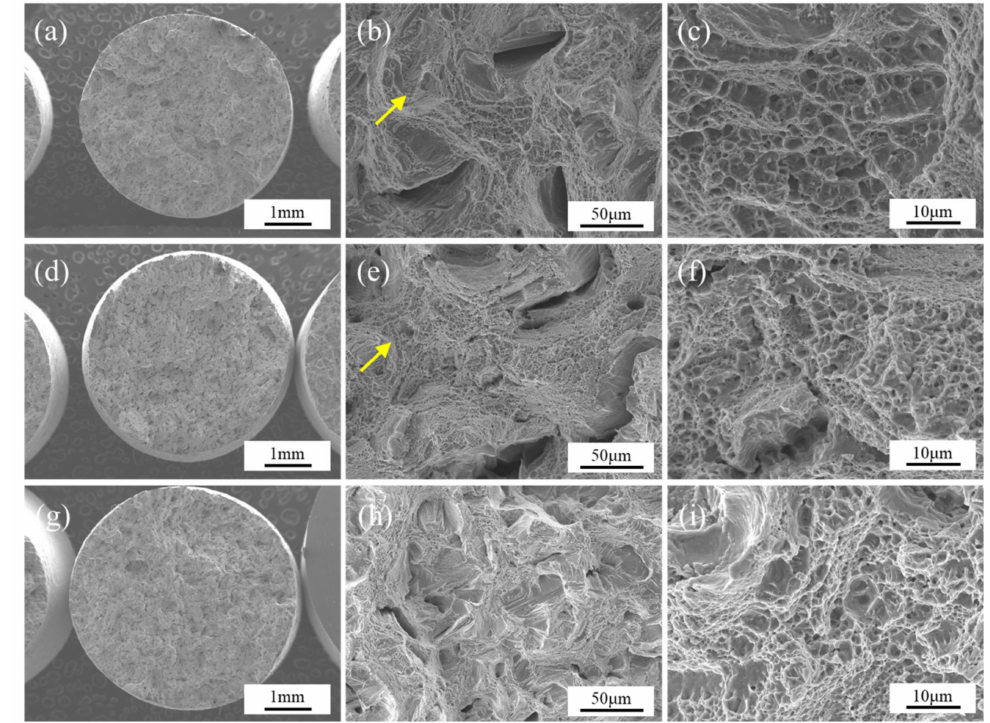
Figure 10. Changes in tensile fracture morphology after heat treatment: ( a – c ) transverse sample; ( d – f ) longitudinal sample; and ( g – i ) 45 ◦